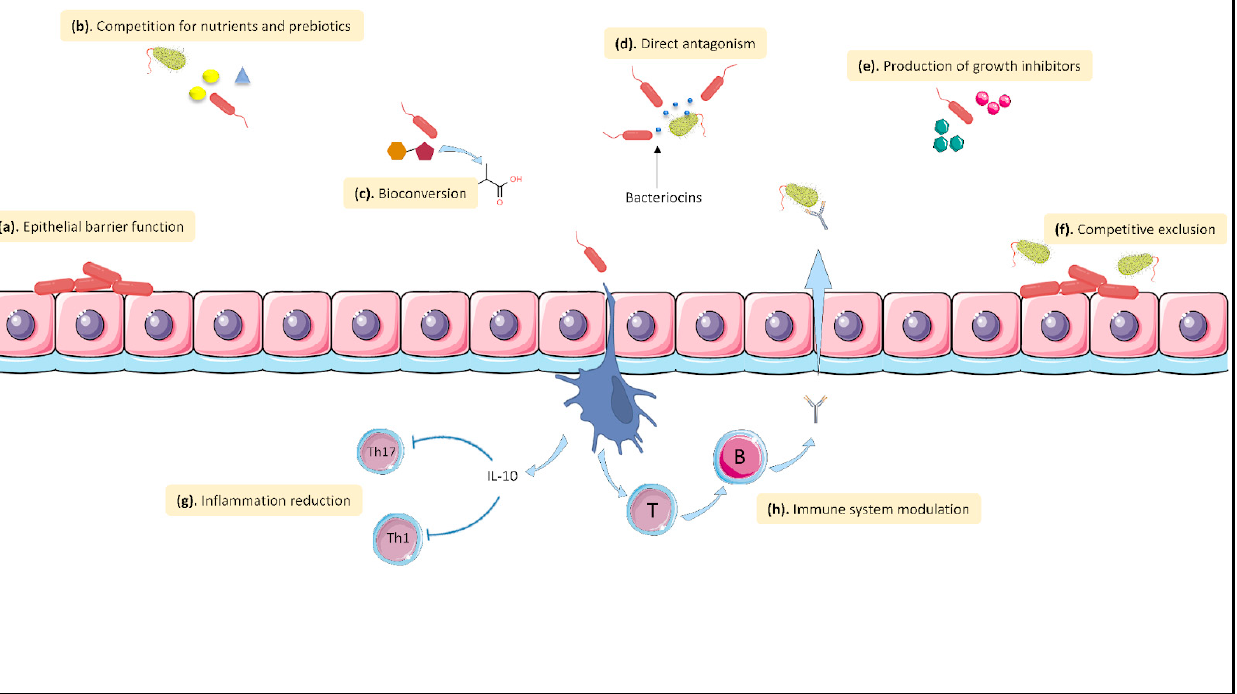
Figure 2. Mechanisms of action of probiotics. Several mechanisms are associated with the antago- nistic effect of probiotics against intestinal pathogens, including the following: ( a ). Enhancement of epithelial barrier function. Probiotic bacteria can maintain the barrier’s integrity, favoring its adhesion to the intestinal mucosa and maintaining the epithelial junctional complex, preventing the entry of pathogens or metabolites that may cause inflammatory responses. ( b ). Competition for nutrients and prebiotics. Probiotic bacteria are capable of competing for nutrients that are necessary for the survival of pathogens. ( c ). Bioconversion. Commensal bacteria can transform organic compounds into bioactive metabolites to generate a better environment. ( d ). Direct antagonism. Probiotic